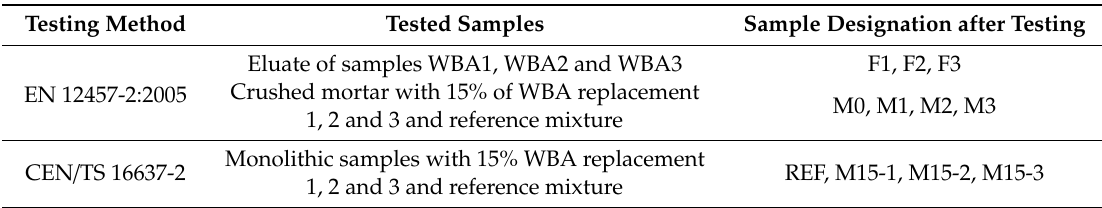
Table 3. Test programme and sample